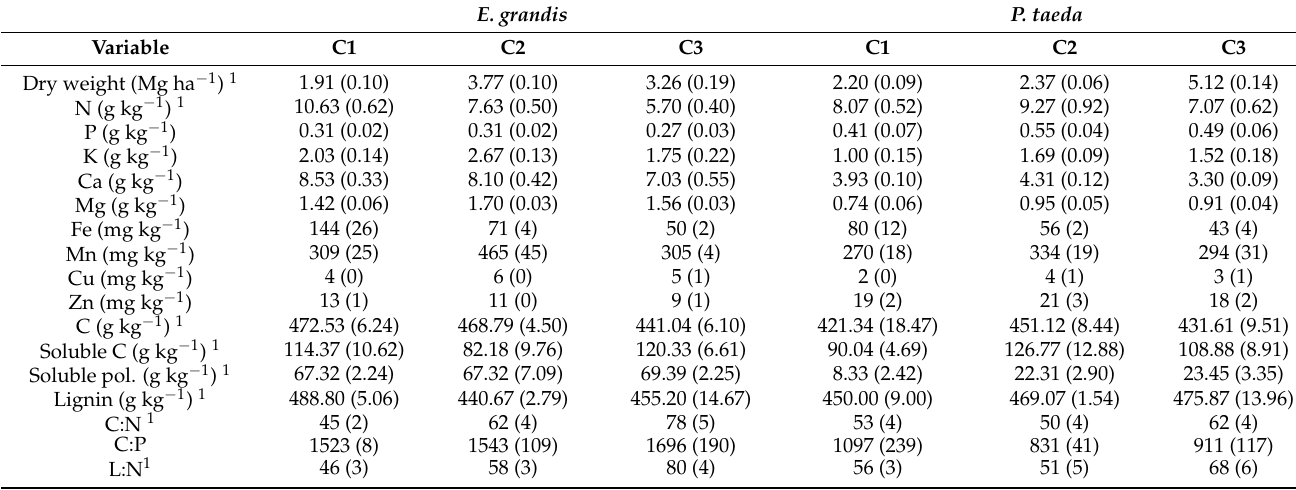
Table 1. Initial dry weight and chemical composition of each considered E. grandis and P. taeda litter layer. E. grandis P.